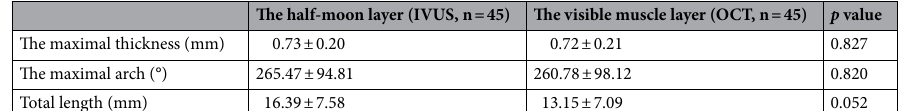
The half-moon layer (IVUS, n = 45) The visible muscle layer (OCT, n = 45) p value